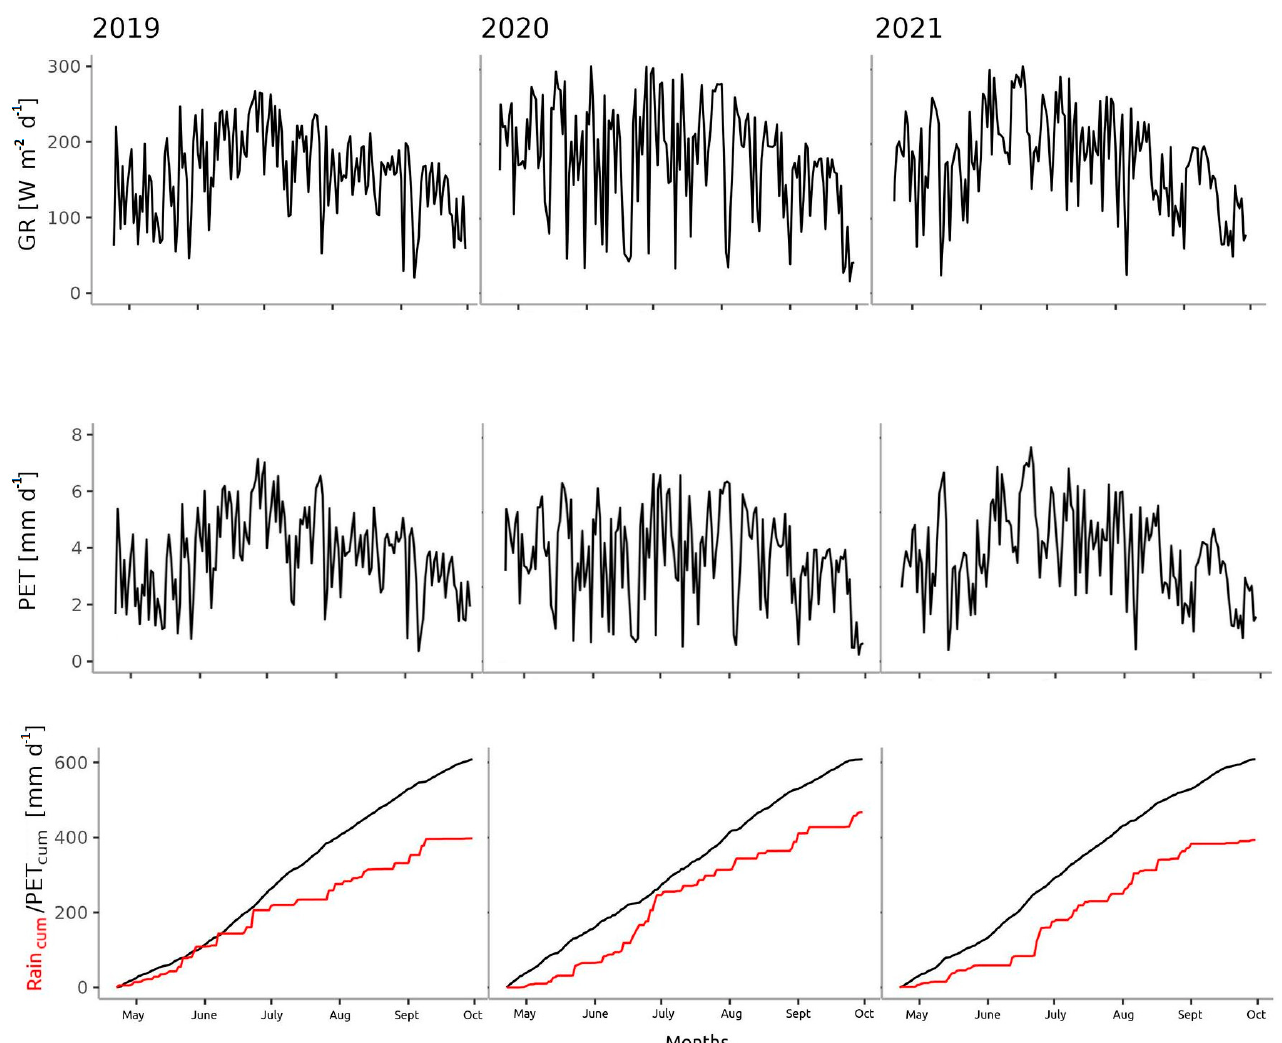
Figure 2. Global radiation (GR), potential evapotranspiration (PET), cumulative potential evapotranspiration (PET cum ) and cumulative precipitation (Rain cum ) during 2019–2021.